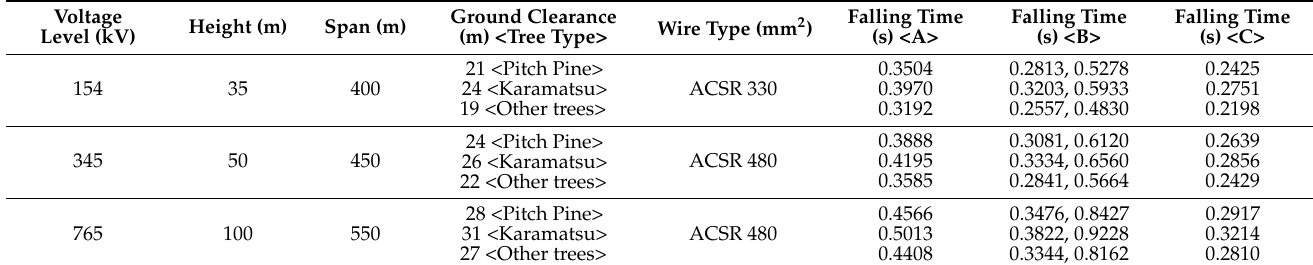
Figure 2. Overhead line fault location overview. Table 1. Transmission line falling